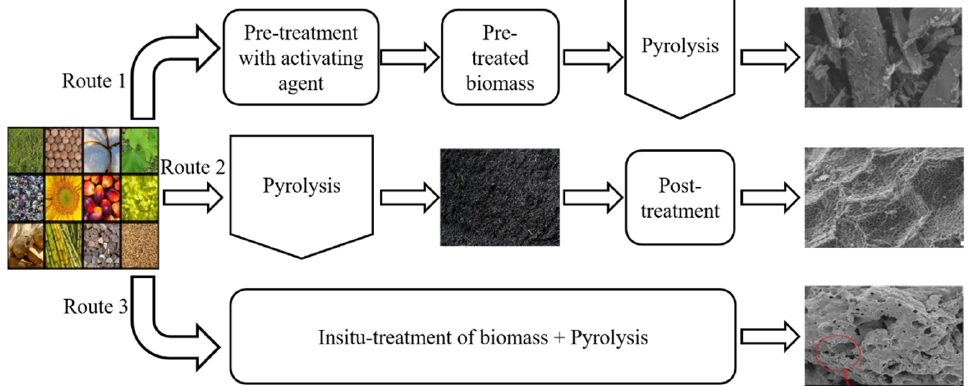
Figure 3. BC surface modification by different routes. Route 1: pretreatment method [69], Route 2: post treatment method [70], Route 3: self-activation [71]. Recreated with permission from Ref.